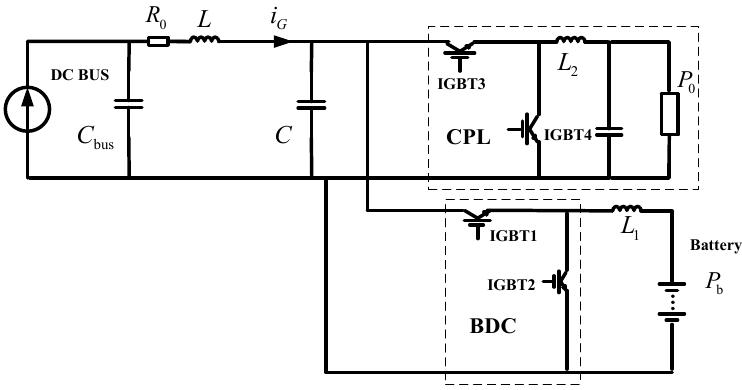
Figure 6. The prototype system schematic.